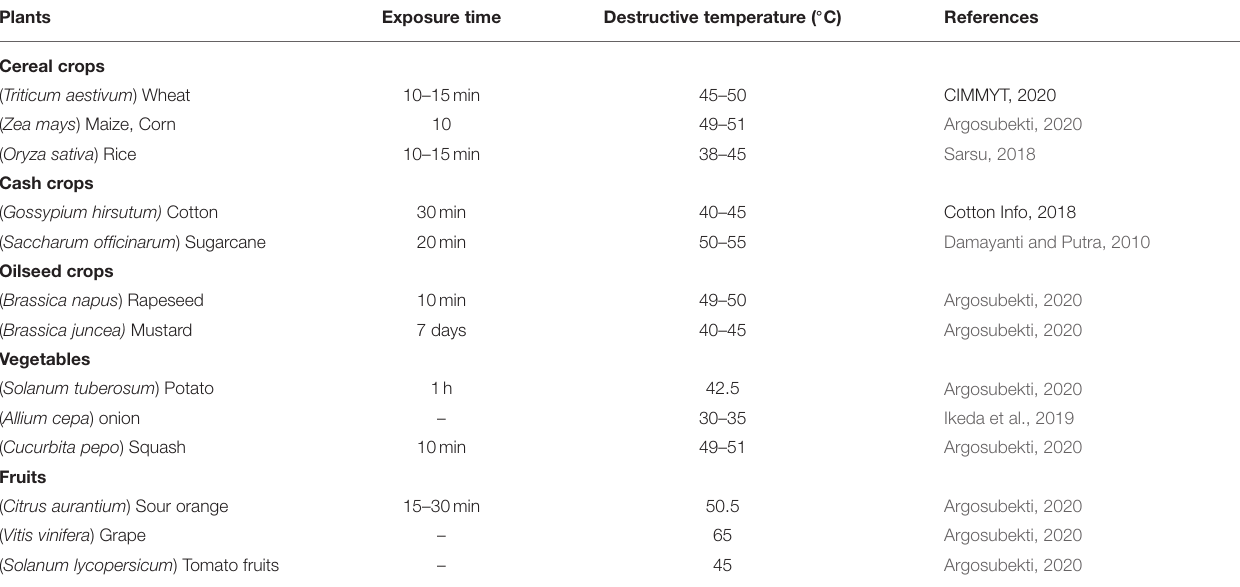
TABLE 1 | Growth destructive temperature of different crops. Plants Exposure time Destructive temperature ( ◦